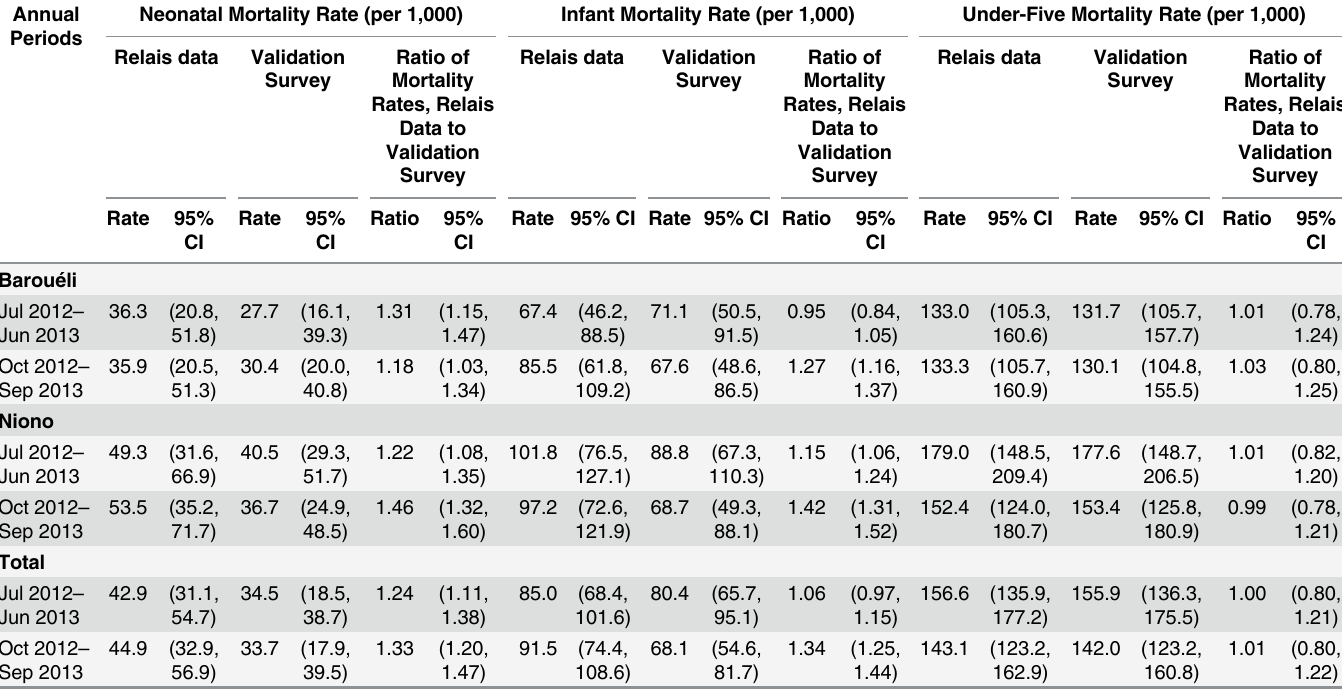
Table 3. Neonatal, infant, and under-five mortality rates from relais records and validation survey and associated confidence intervals. Annual Neonatal Mortality Rate (per 1,000) Infant Mortality Rate (per Periods